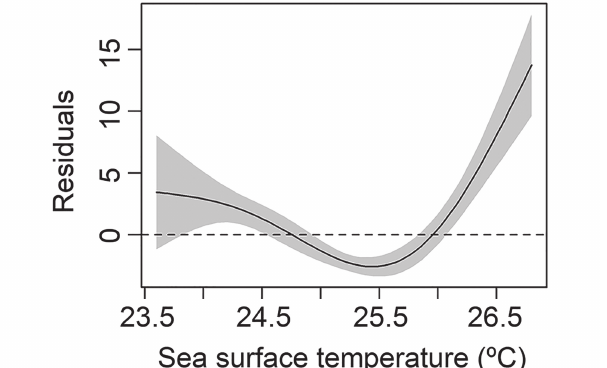
Fig. 4. Significant effect of the continuous variable sea surface temperature upon the maximum diving depth of the Carcharhinus leucas tagged, assessed with a generalized additive model (GAM). The horizontal dashed line and shaded area depict null effect and 95% confidence intervals,